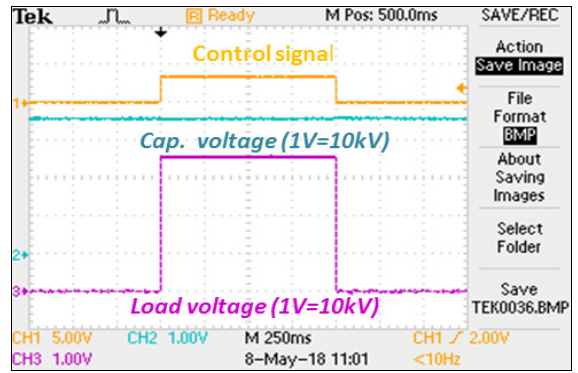
Fig. 6: Test result of 35 kV for 50µs (rise/fall time: ~5µs)